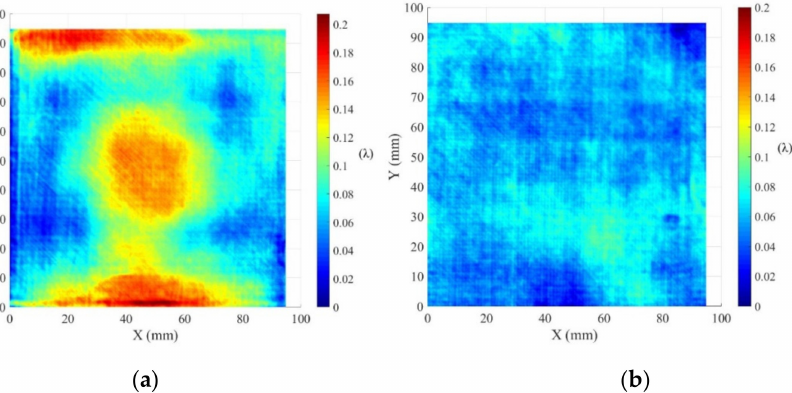
Figure 14. The error map before and after deterministic polishing with the force control: ( a ) Initial surface error map; ( b ) The residual surface error